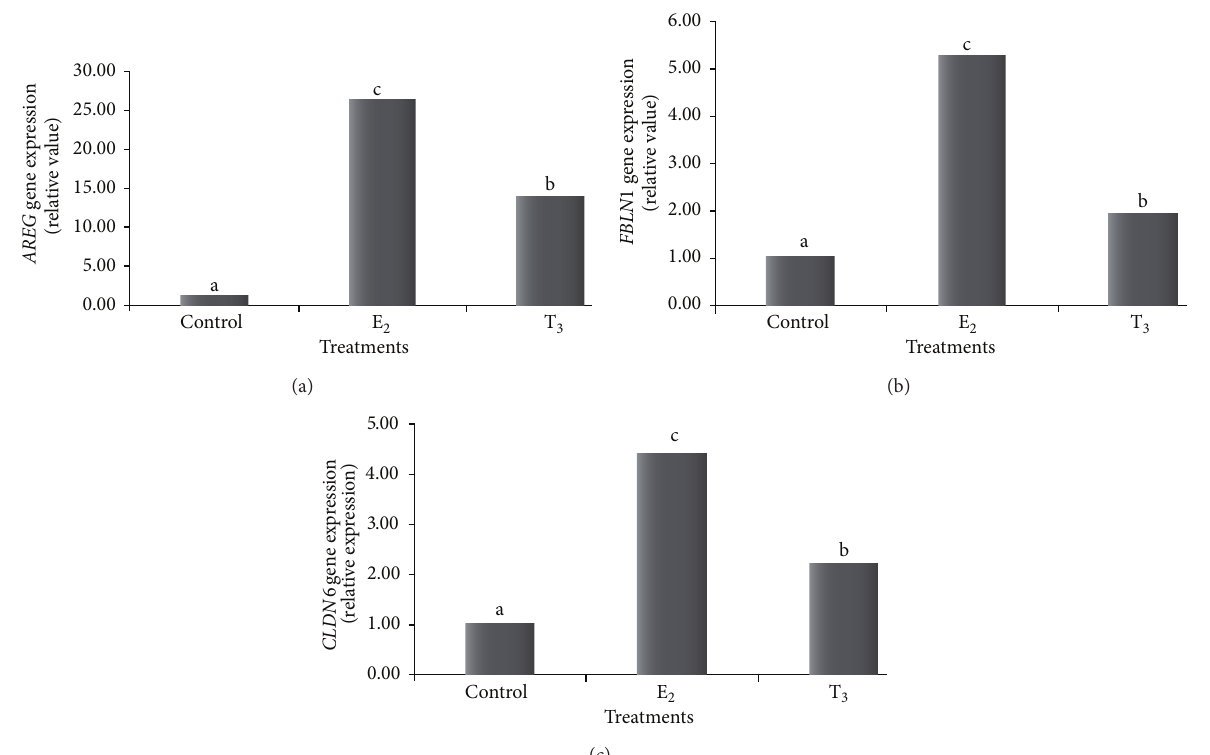
Figure 2: (a) Expression of AREG gene analyzed by real-time PCR in MCF-7 cells. (b) Expression of FBLN1 gene analyzed by real-time PCR in MCF-7 cells. (c) Expression of CLDN6 gene analyzed by real-time PCR in MCF-7 cells. Results are expressed relative to the expression in the control cells for E 2 -treated (10 −8 M) and T 3 -treated (10 −8 M) MCF-7 breast carcinoma cells. The use of different letters indicates that there was a statistical difference of 𝑃 < 0.05